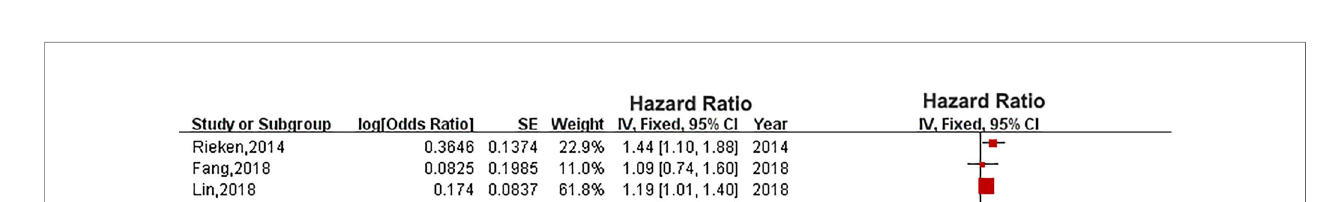
FIGURE 4 | Forest plot of the impact of diabetes on overall survival.